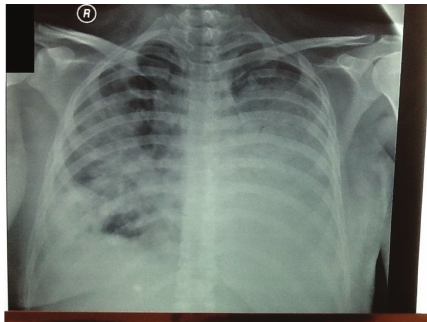
Figure 2: Chest radiograph of day 2 showing di ff use alveolar opacities extending to the left upper lung fields, but in the right middle and lower lobe.